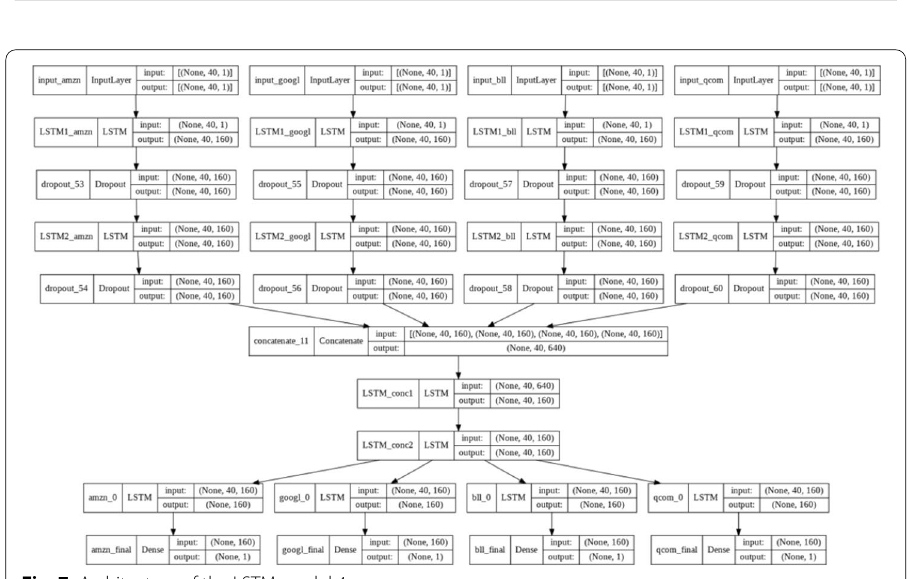
Fig. 6 Architecture of the LSTM model 3